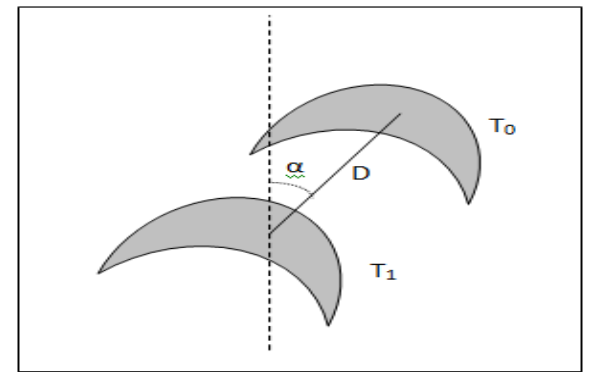
Figure 9: Determination of distance and direction of dune mobility